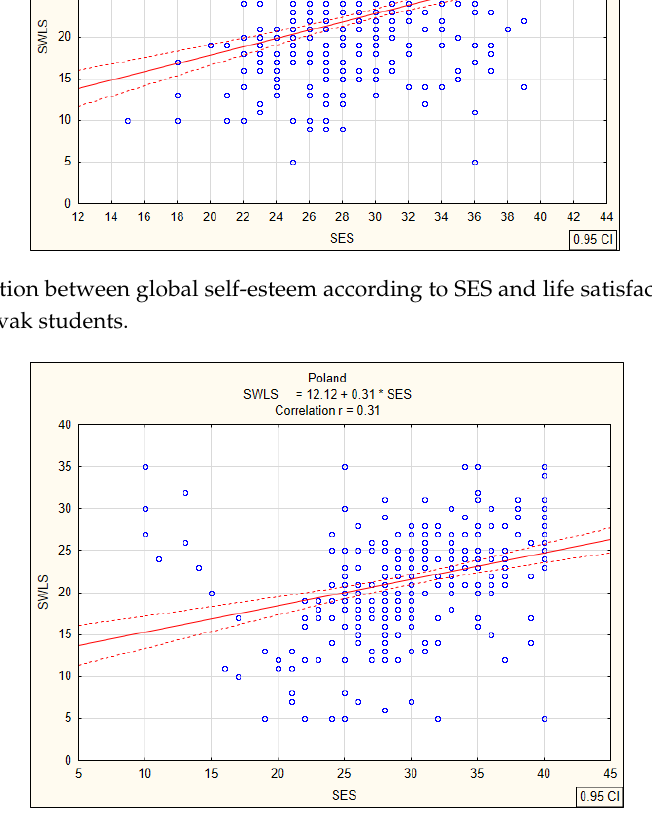
Figure 6. Correlation between global self-esteem according to SES and life satisfaction according to SWLS among Polish students.